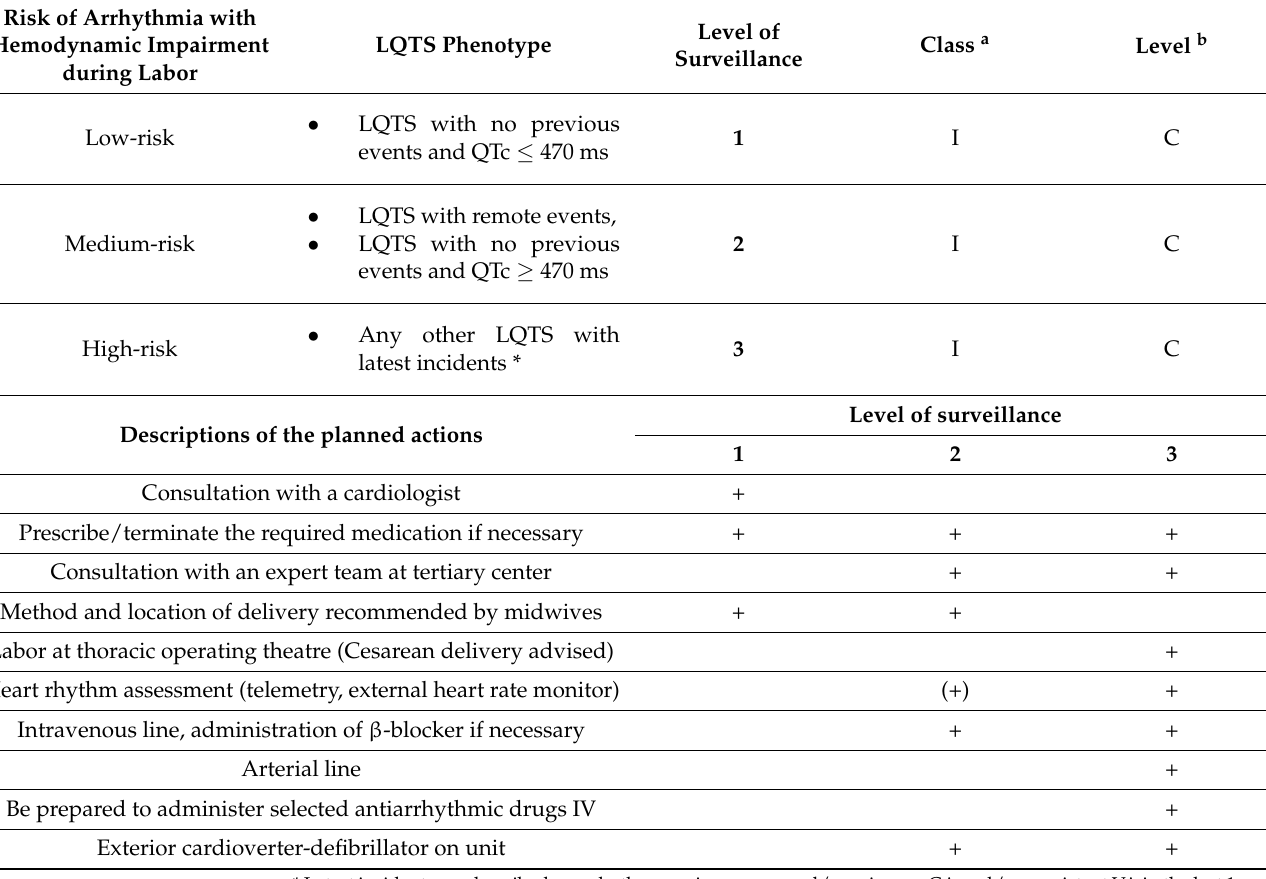
Table 1. Recommended level of care during labor for women with LQTS. Adapted from the 2018 ESC guidelines [15] and Roston et al. [28].